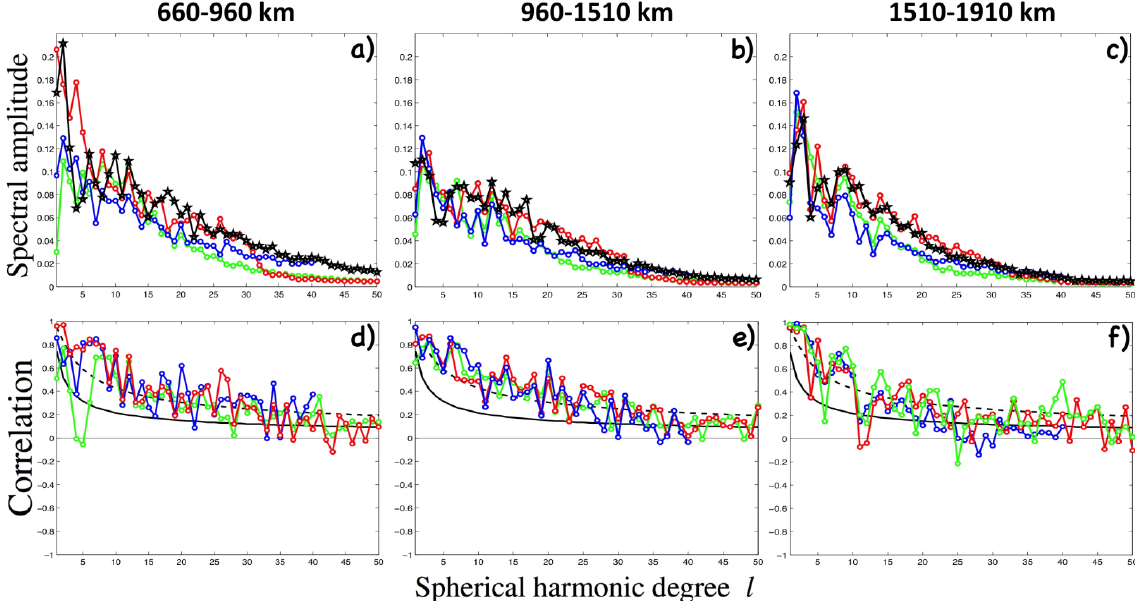
Fig. 8. (a–c) Spectral amplitude as a function of spherical harmonic degree l = 1–50 for four tomographic models in mid lower-mantle: our model MB pref (black), S40RTS (blue, plotted up to l = 40), PRI-S05 (red), and TX2007 (green). (d–f) Correlation as a function of degree l between our model MB pref and the three other models: S40RTS (blue), PRI-S05 (red), and TX2007 (green). The black dashed- and solid-lines indicate the 95 and 66% significance levels,